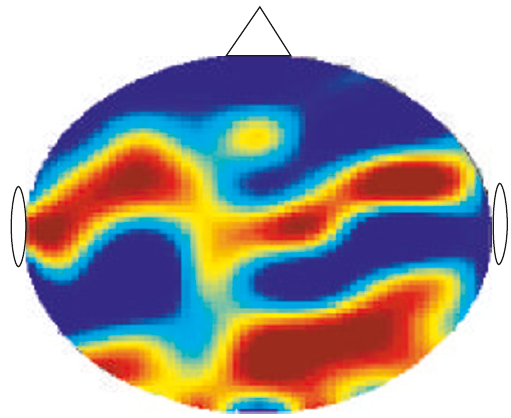
Figure 18: Distribution of auditory P300 over the scalp electrodes. It is seen that the auditory P300 is distributed di ff erently over the electrodes than the visual